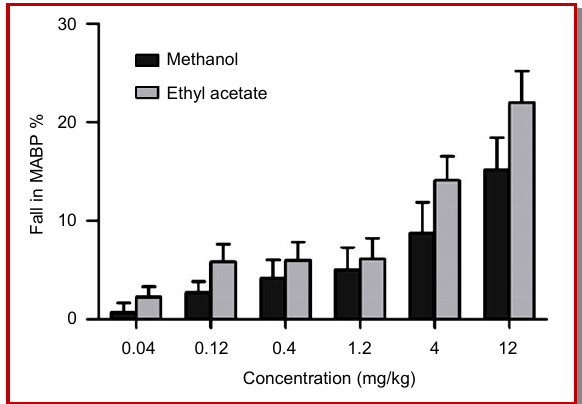
Figure 4: Dose-dependent hypotensive effect of methanol and